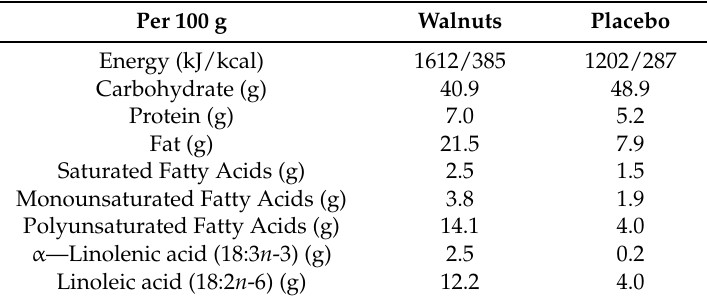
Table 2. Composition of the banana bread. Per 100 g Walnuts Placebo Energy (kJ/kcal)